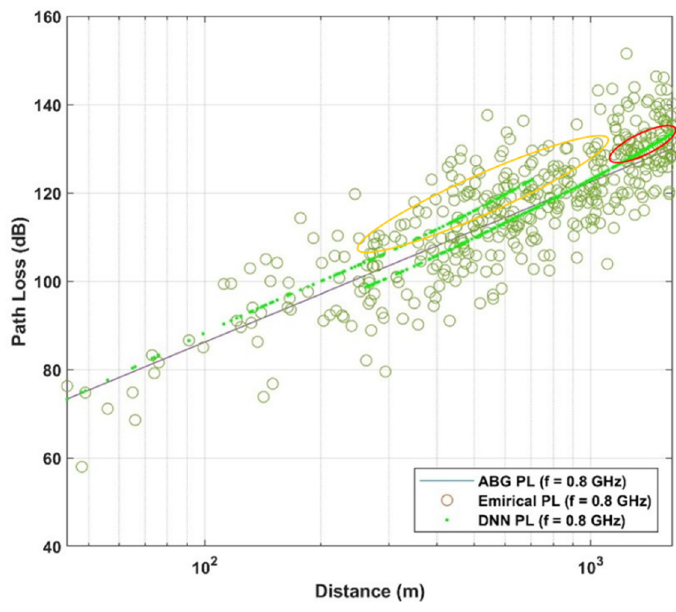
Figure 10. Path loss models and empirical data for low 5G band.